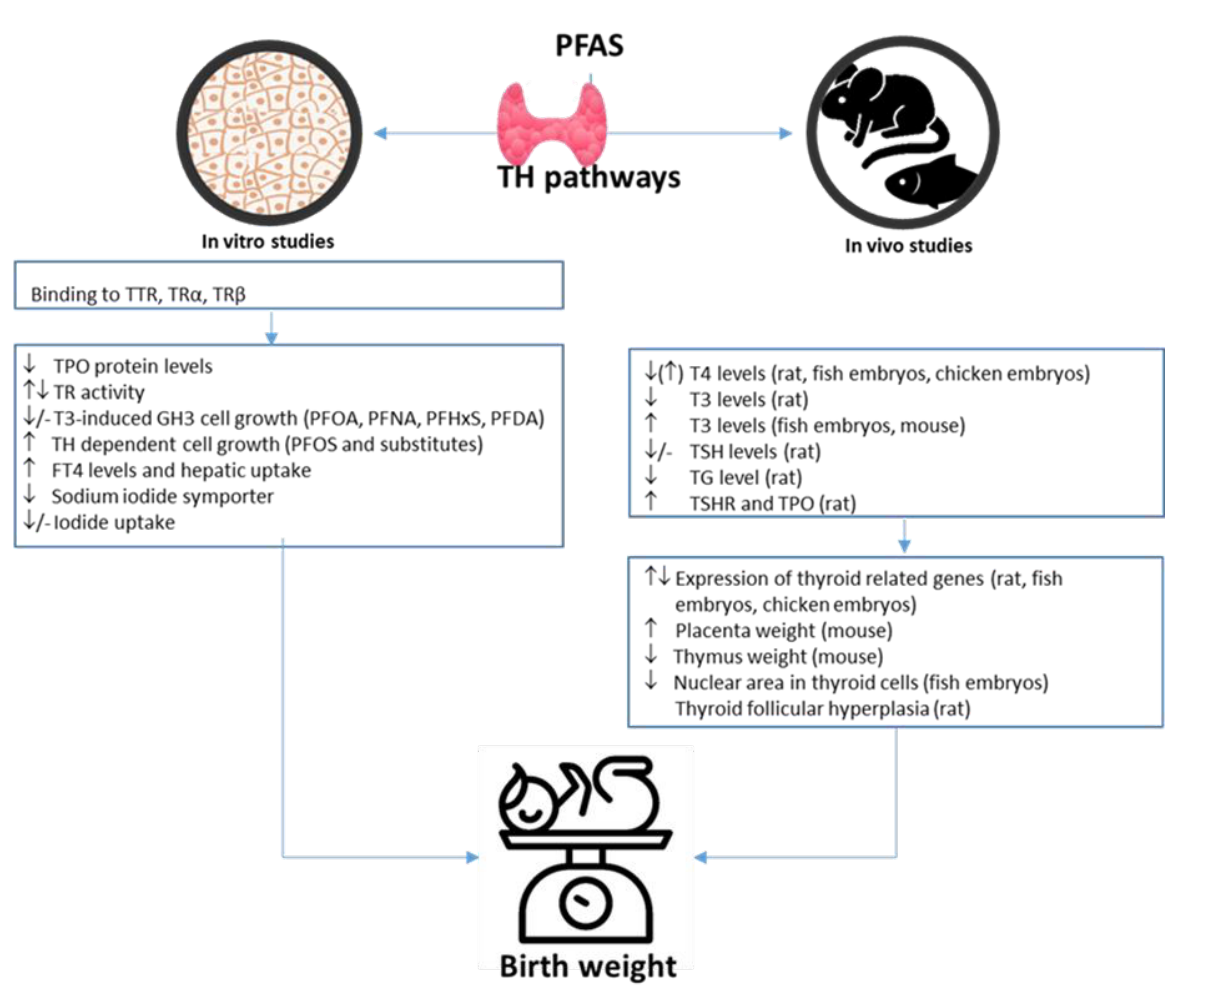
Figure 5. Possible PFAS-induced thyroid effects involved in birth weight. PFAS, per- and polyfluoroalkyl substances; TH, thyroid hormone; TPO, thyroperoxidase; TR, thyroid hormone receptor; T4, thyroxine; T3, triiodothyronine; FT4, free T4; TSH, thyroid-stimulating hormone; TG, thyroglobulin; TSHR, TSH receptor.